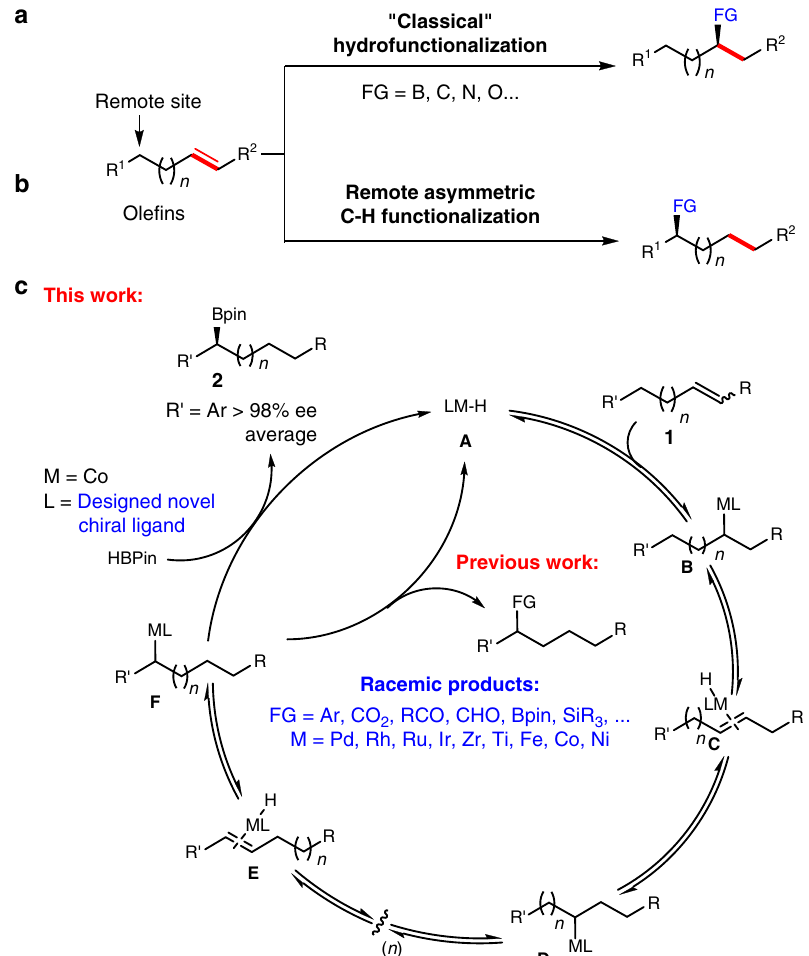
Fig. 1 Remote functionalization of alkenes via sequential alkene isomerization/functionalization. a Asymmetric hydrofunctionalization of alkenes. b The concept of asymmetric remote functionalization of alkenes via isomerization. c A general pathway for the remote functionalization of alkenes via